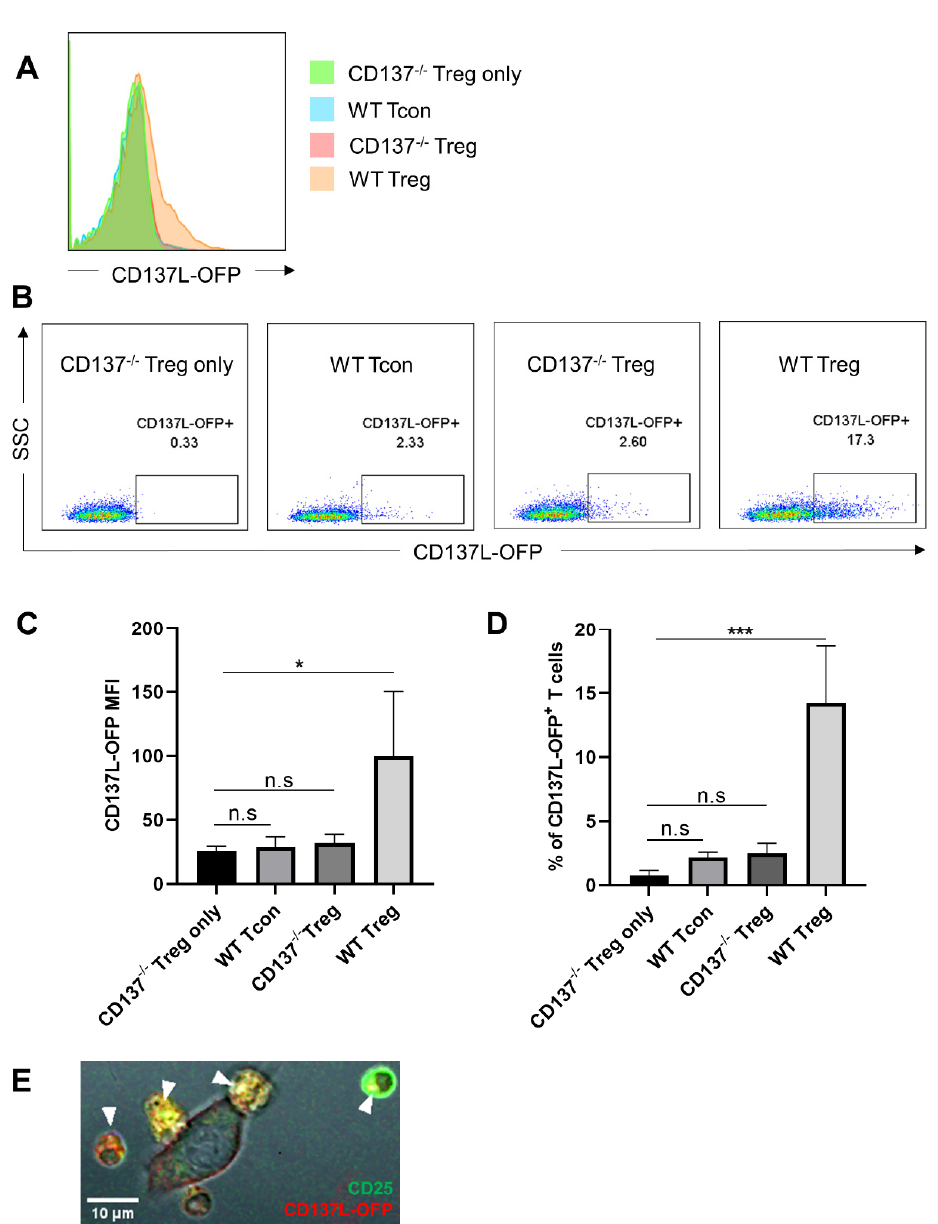
Treg. Graph shows relative CD137L MFI on WT RAW 264.7 cells after the coculture. All graphs show means ± SD, * p < 0.05, ** p < 0.01, two-tailed unpaired Student’s t test. Data are representative of three independent experiments.